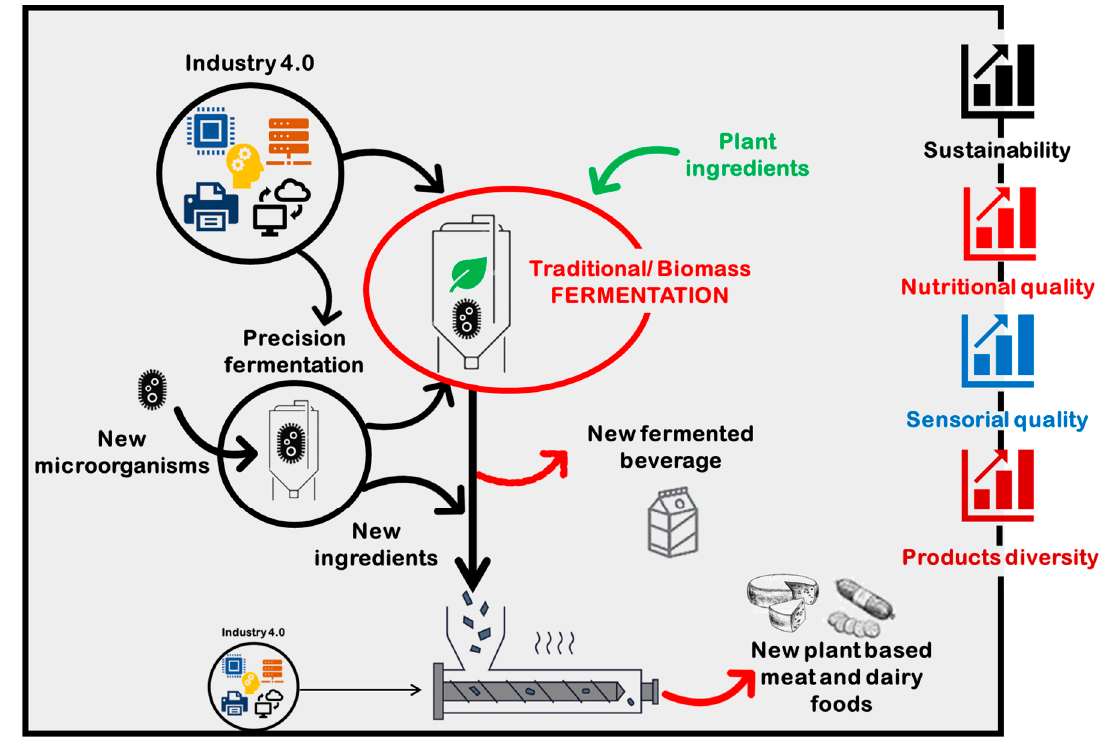
Figure 1. The use of fermentation to make innovative plant-based products.